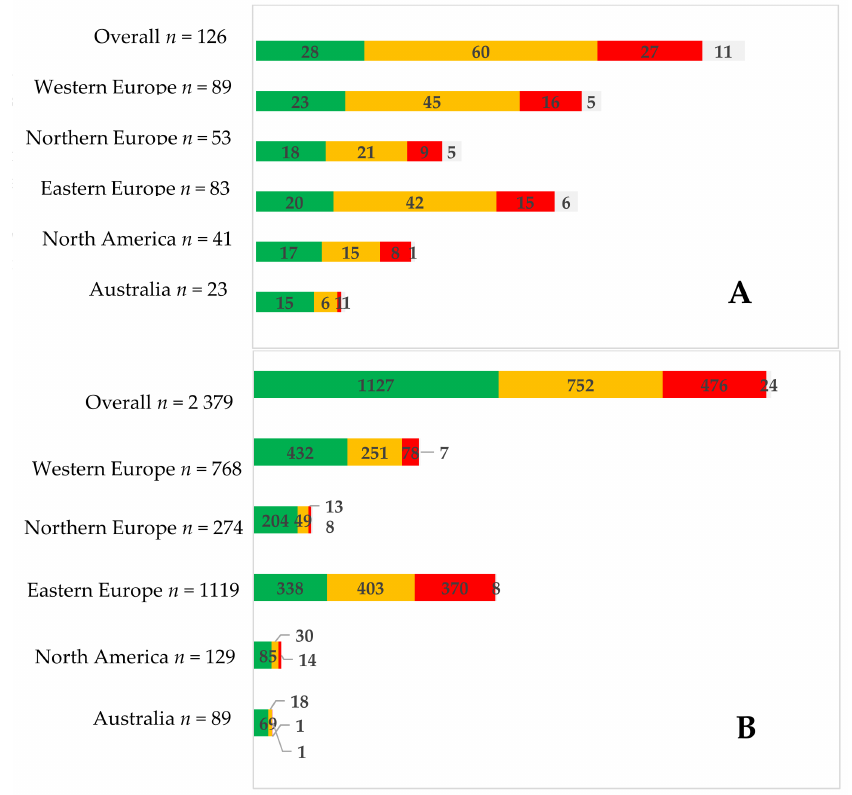
Figure 1. Herbal medicine used ( A ) and number of women who used them ( B ) by safety classification (green = safe; orange = caution; red = contraindicated; white = unknown). From Kennedy et al. [18].